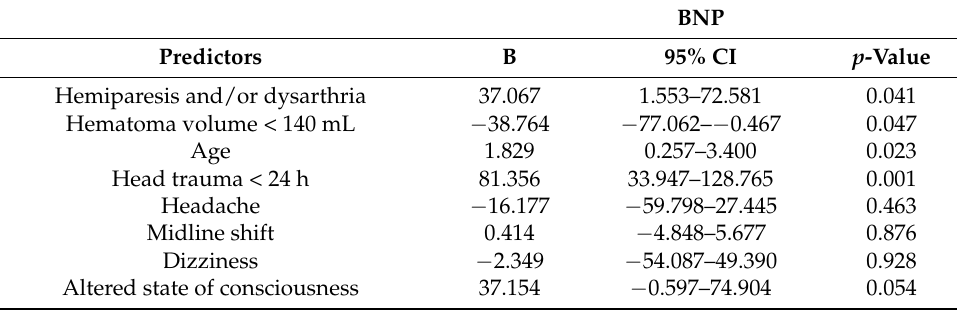
Table 4. Predictors of Increased